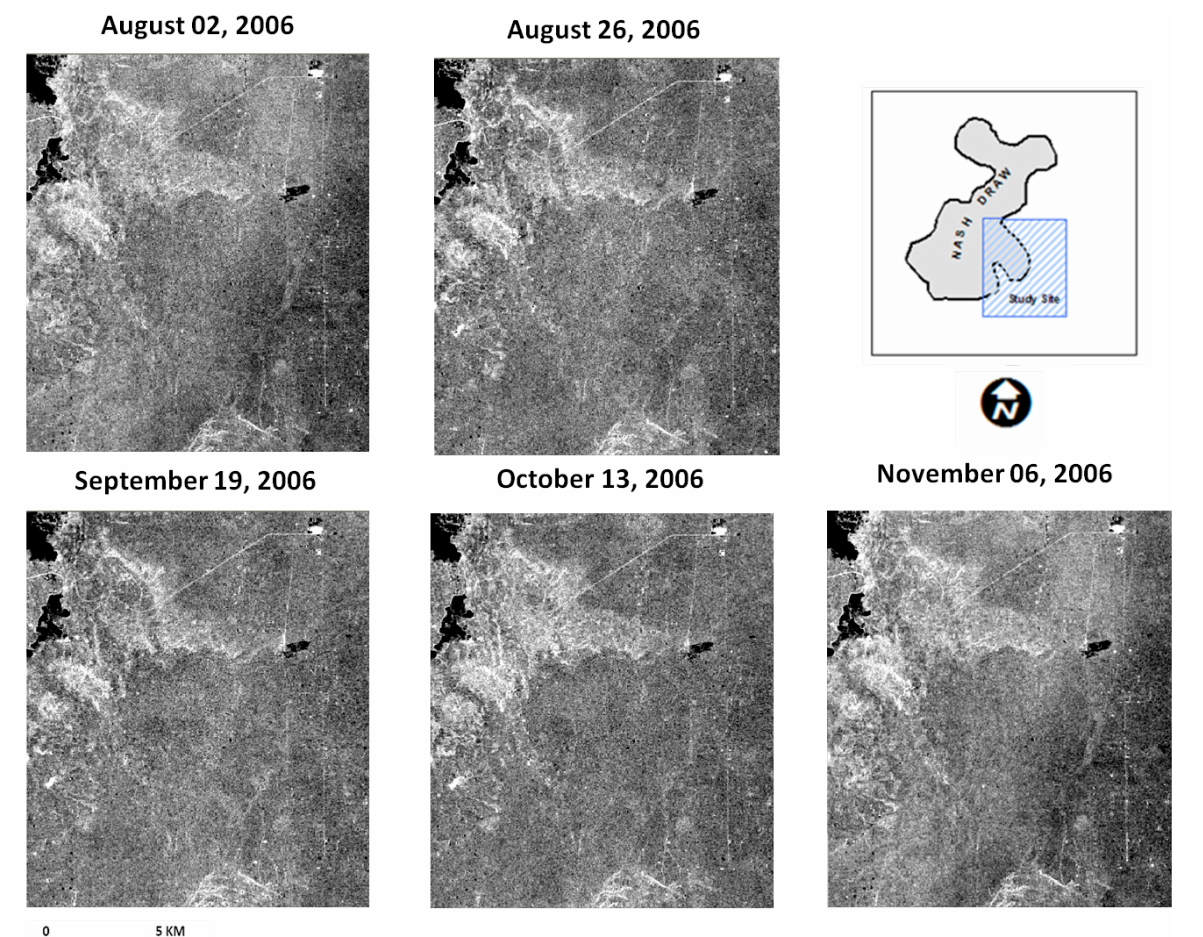
Figure 2. Time series of acquired SAR imagery.